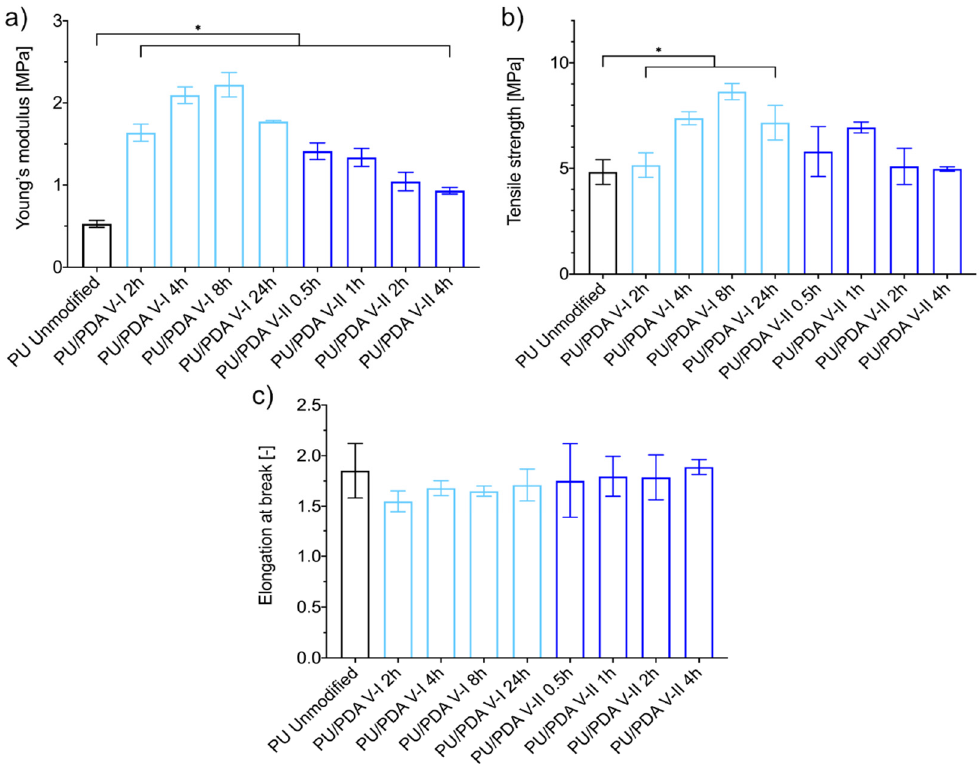
Figure 6. Mechanical properties of unmodified and modified PU nanofibrous materials: ( a ) Young’s modulus, ( b ) tensile strength, and ( c ) elongation at break. The asterisk (*) denotes a significant ( p < 0.01) difference among the mean value of the mechanical properties of nanofibrous materials.